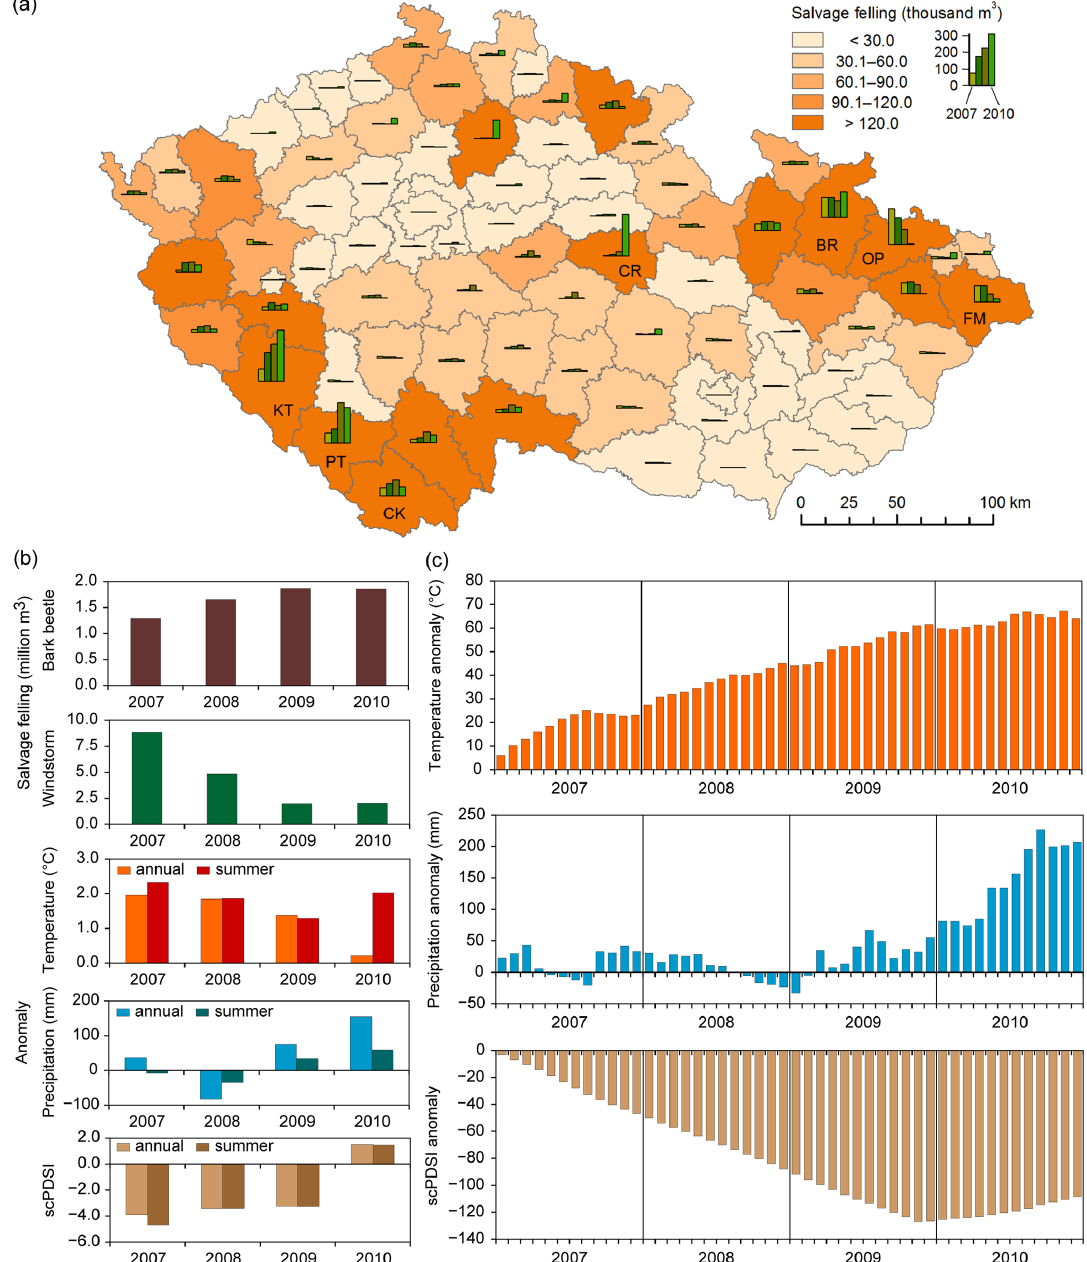
Figure 9. Bark beetle outbreak of the 2000s on the territory of the Czech Republic: (a) the volume of bark beetle salvage felling in 2007– 2010 in individual districts; (b) annual bark beetle and windstorm salvage felling, annual and summer anomalies of temperature, precipitation, scPDSI-12, and scPDSI-3 in 2007–2010; (c) cumulative monthly anomalies of temperature, precipitation, and scPDSI in 2007–2010 (1961– 1990 reference period). Abbreviations of districts: BR – Bruntál; CK – ˇCeský Krumlov; CR – Chrudim; FM – Frýdek-Místek; OP – Opava; KT – Klatovy; PT –